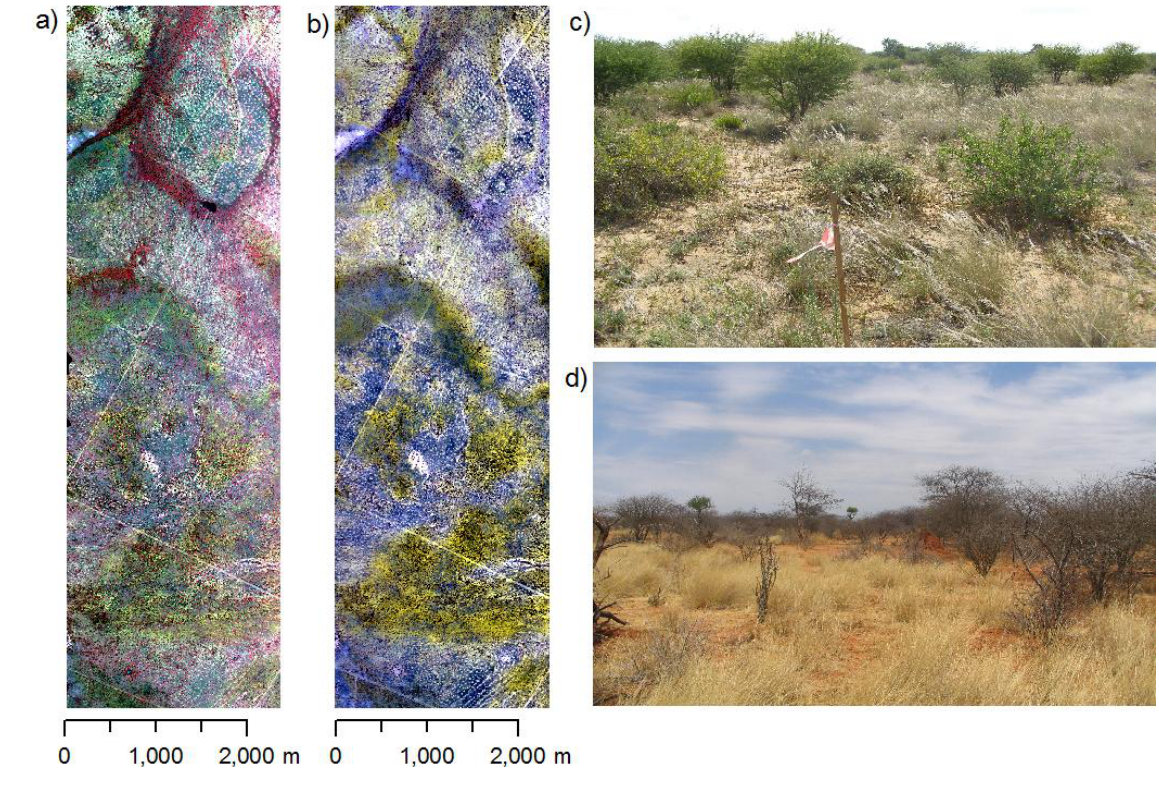
Figure 2. HyMap images and photos from the study area showing the differences between rainy and dry season in the study area. (a) Rainy season image (April, 2004, CIR). (b) Dry season image (October, 2005, CIR). (c) Rainy season vegetation aspect (d) Dry season vegetation